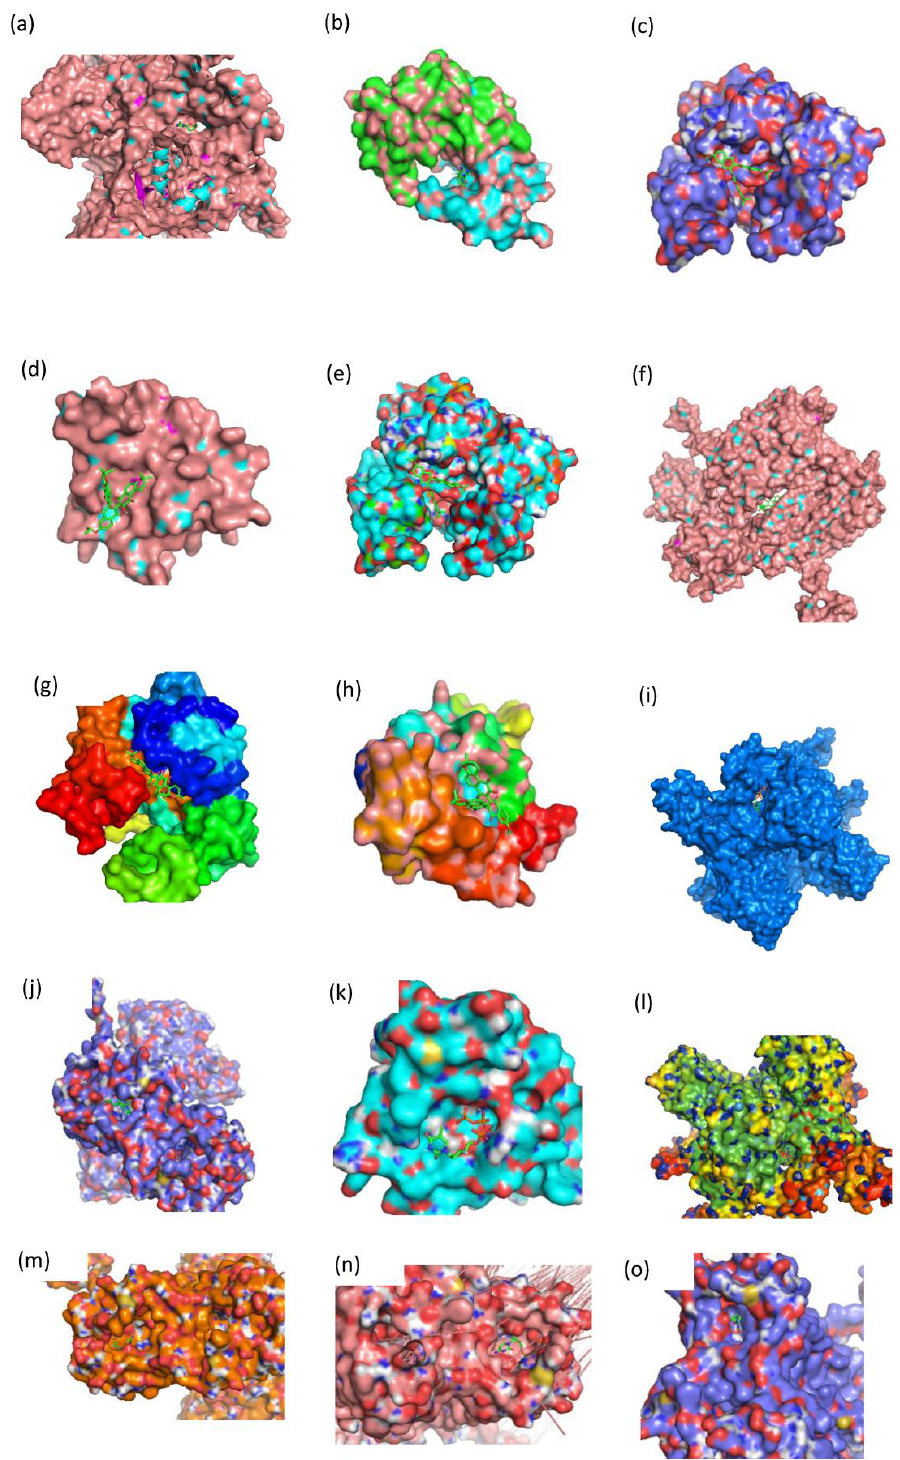
Figure 10. The binding modes of six compounds in their respective binding sites. ( a ): CHEMBL38700-CD299. ( b ): CHEMBL38700-PR. ( c ): CHEMBL1223975-PARB. ( d ): CHEMBL1223977-IN. ( e ): CHEMBL1223977-PARB. ( f ): CHEMBL1223979-CXCR4. ( g ): CHEMBL1223979-PARB. ( h ): CHEMBL1223985-IN. ( i ): CHEMBL2092833-CD299. ( j ): CHEMBL2092833-CXCR4. ( k ): CHEMBL2092833-IN. ( l ): CHEMBL20 92835-CD299. ( m ): CHEMBL2092835-CXCR4. ( n ): CHEMBL2092835-RT. ( o ):